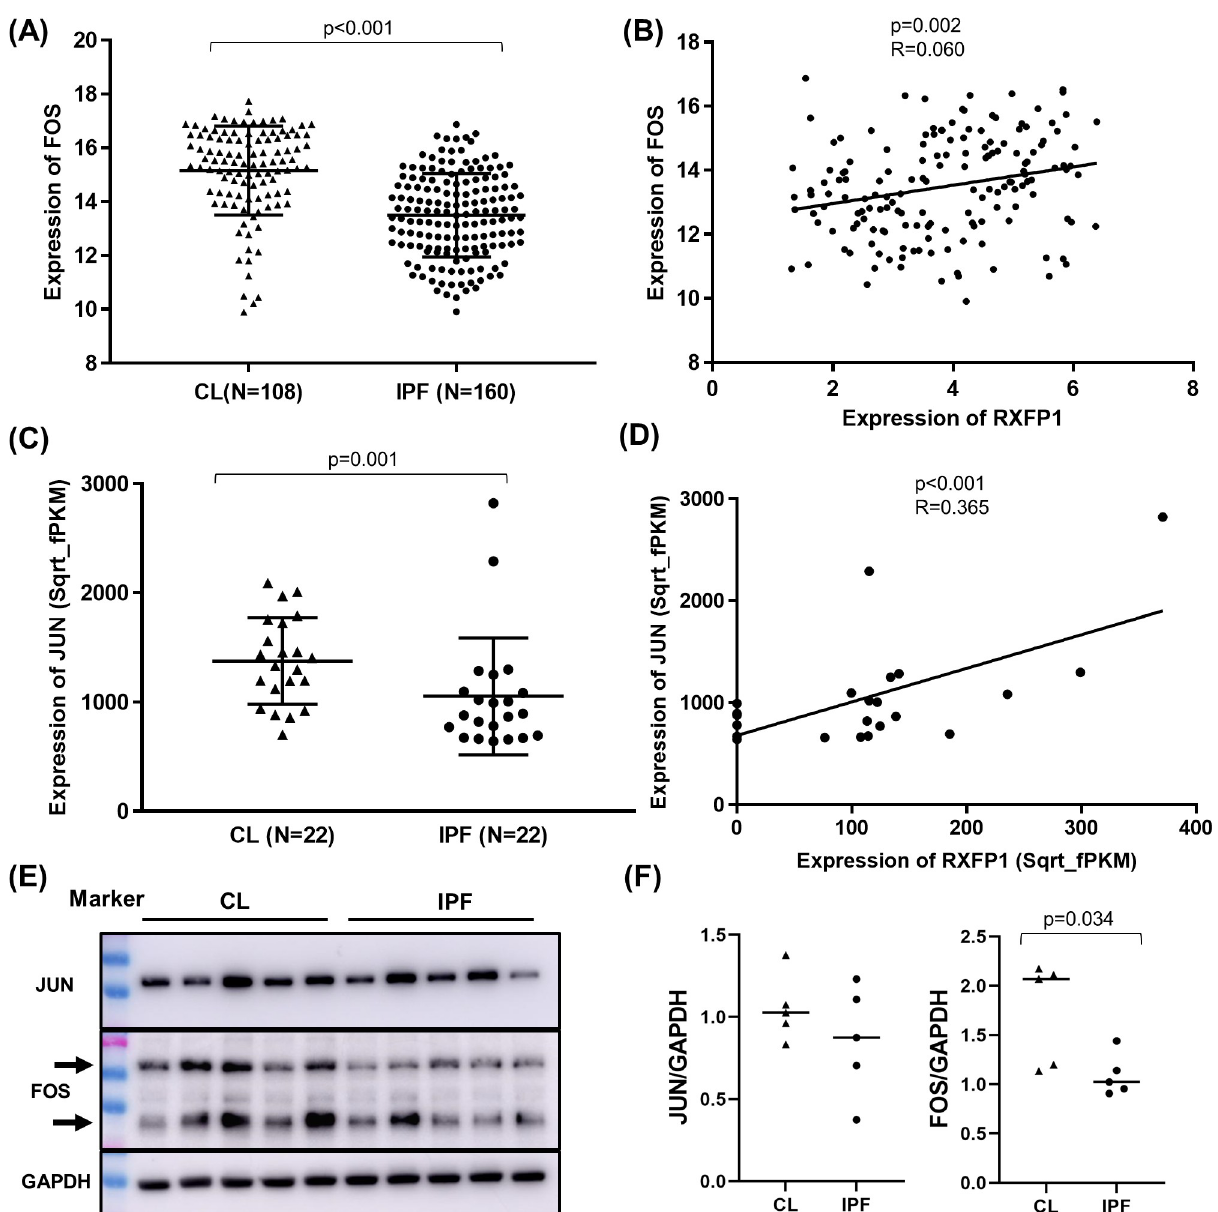
Fig 6. Lower expression of JUN and FOS and positive correlation to RXFP1 in control and IPF lungs and lung fibroblasts. Lung tissue expression levels of FOS analyzed using microarray (A) and JUN analyzed using bulk RNA sequencing (C) from the publicly available Lung Genomics Research Consortium (LGRC) gene expression dataset (GEO accession GSE47460; http://www.lung-genomics.org/) were compared between control (108 subjects for FOS and 22 subjects for JUN ) and idiopathic pulmonary fibrosis (IPF) (160 subjects for FOS and 22 subjects for JUN ). The mean and standard deviation for each group and Mann-Whitney U test p-values are shown. Correlation of FOS (B) and JUN (D) gene expression levels with RXFP1 was analyzed in IPF lungs (160 subjects for FOS and 22 subjects for JUN ) using linear regression and the R 2 and p-value are shown. (E) Protein levels of JUN and FOS in independent IPF and control lung fibroblast lines analyzed by western blot with antibodies specific for JUN (rabbit mAb, Cell signaling technology #9165) and FOS (mouse mAb, Protein tech # 66590-1-IG). GAPDH (rabbit mAb Abcam Abcam ab181602) was used as a sample loading control. Total proteins isolated from confluent fibroblasts using radioimmunoprecipitation assay (RIPA) were separated by SDS-PAGE gel electrophoresis. (F) Densitometry of the results on (E) using the ImageJ software (National Institutes of Health) [29]. For FOS, total density of both bands was used for each sample. A total of 10 independent lung fibroblast lines (5 IPF and 5 control) were analyzed.